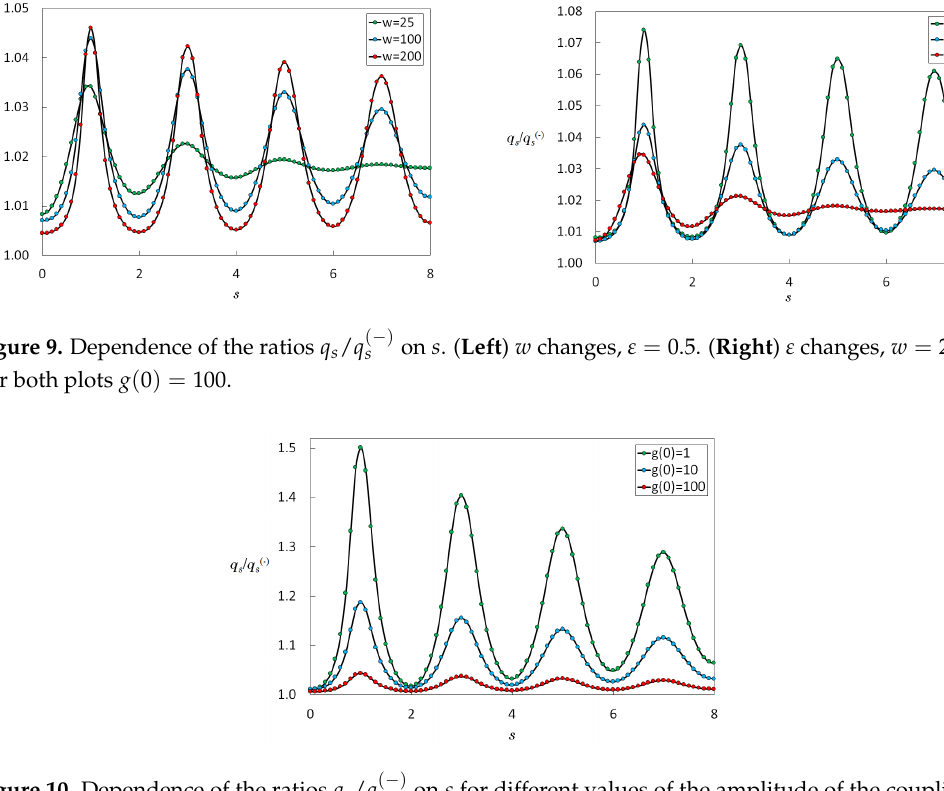
( − ) Figure 10. Dependence of the ratios q s / q s on s for different values of the amplitude of the coupling constant g ( 0 ) . The parameters w and ε are fixed and equal to w = 200 and ε = 0.5,